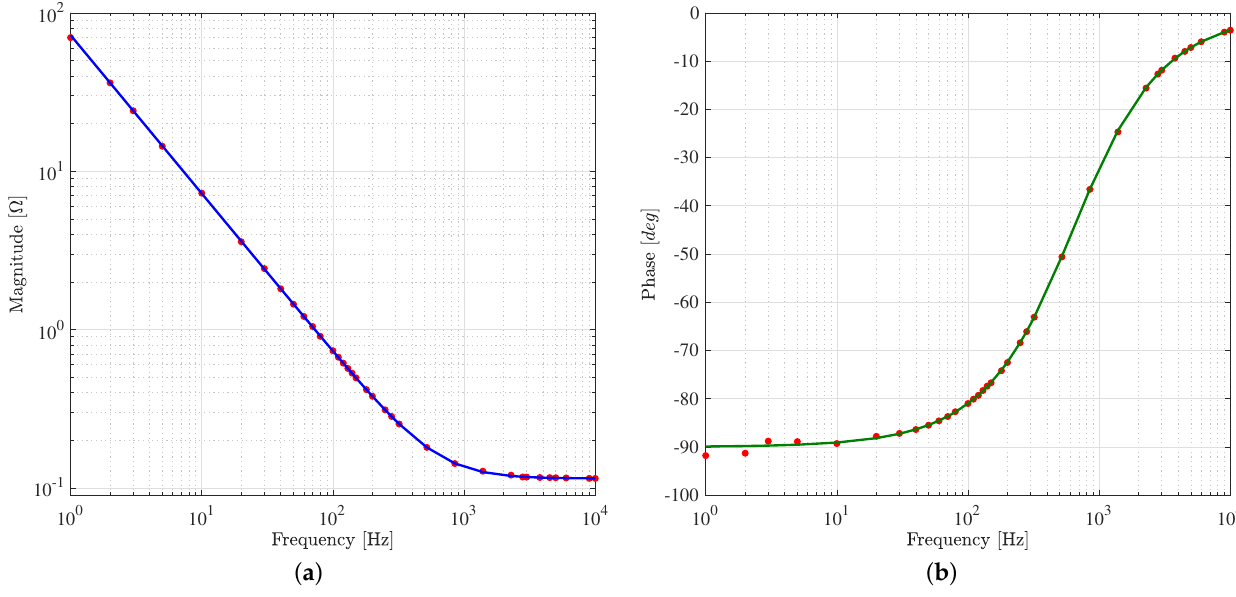
Figure 12. Multiple curve-fitting for magnitude and phase with MPPT ON at 750 W/m 2 . ( a ) Magnitude. ( b )